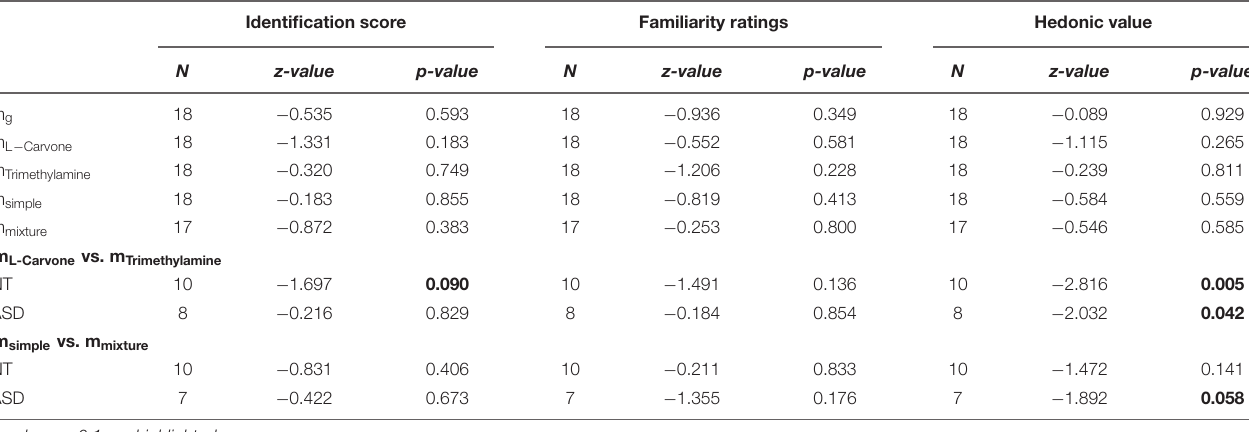
TABLE 1 | Inter-group and intra-group comparison for odor identification, familiarity and pleasantness: sample size ( N ), observed z -value and p -value for each parameter and each variable. Identification score